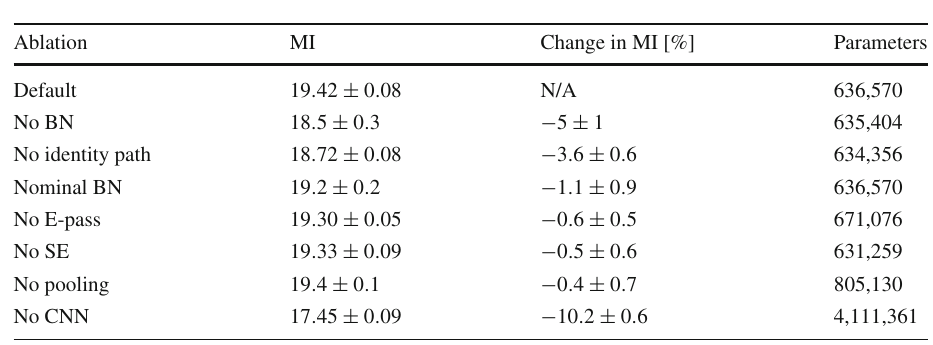
Table 5 Software used for the